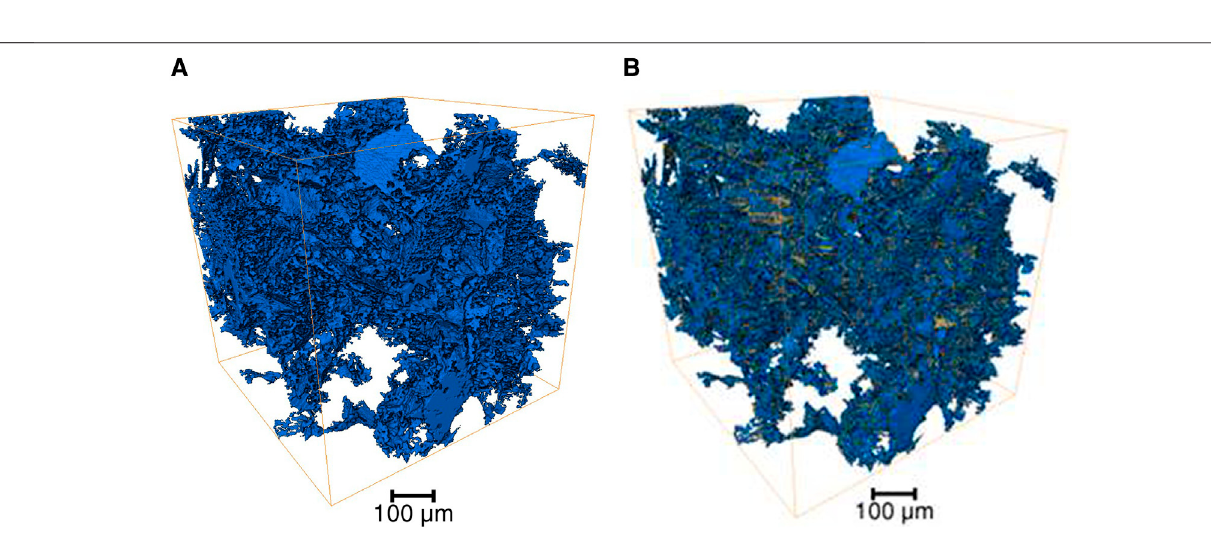
FIGURE 2 | Effect of pore angle in 3D. (A) Original pore. (B) Pore and angles (gray).